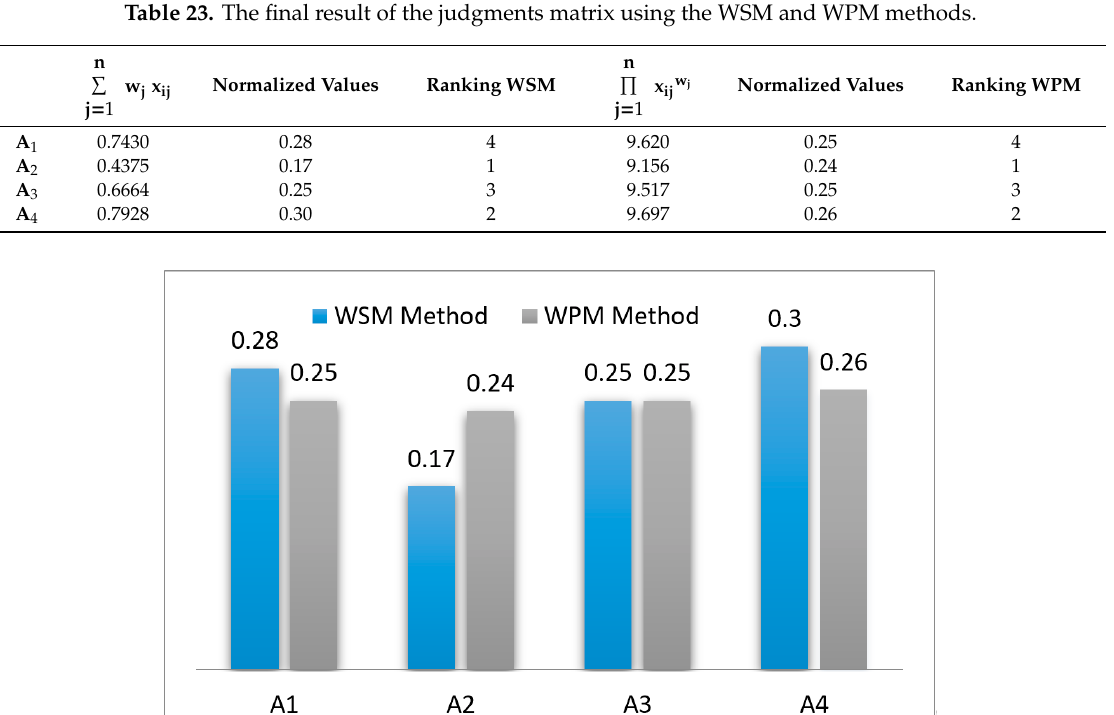
Figure 8. Final ranking using the WSM and WPM methods.